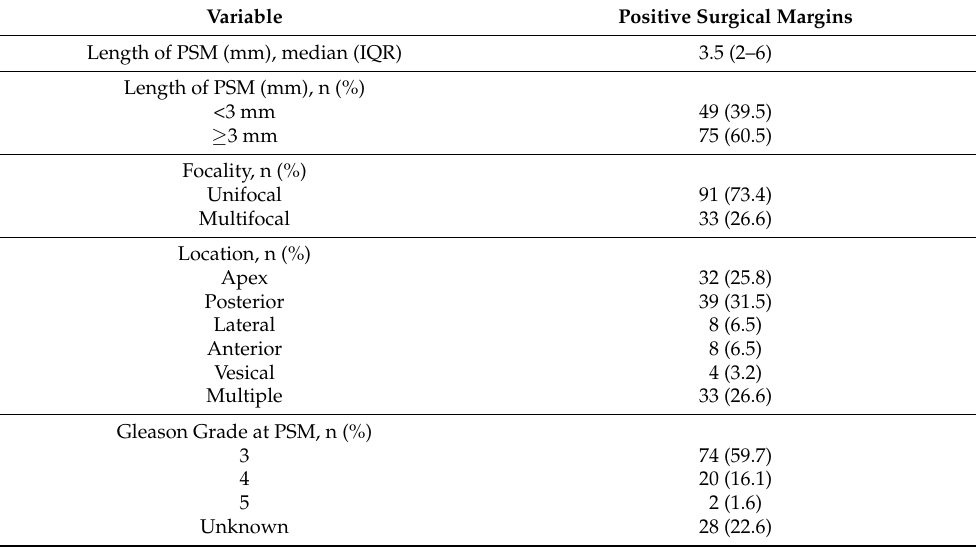
Table 2. Characteristics of the positive surgical